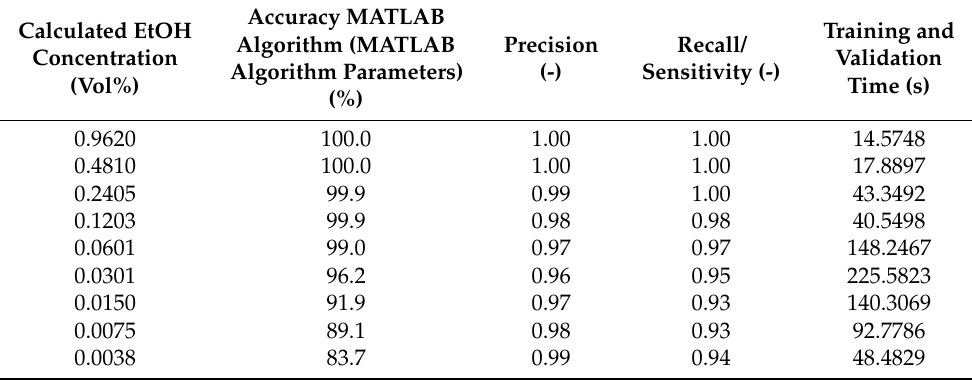
Table 3. Calculated mean value for accuracy, precision, recall/sensitivity, and time required for training and validation for each concentration obtained from the MATLAB